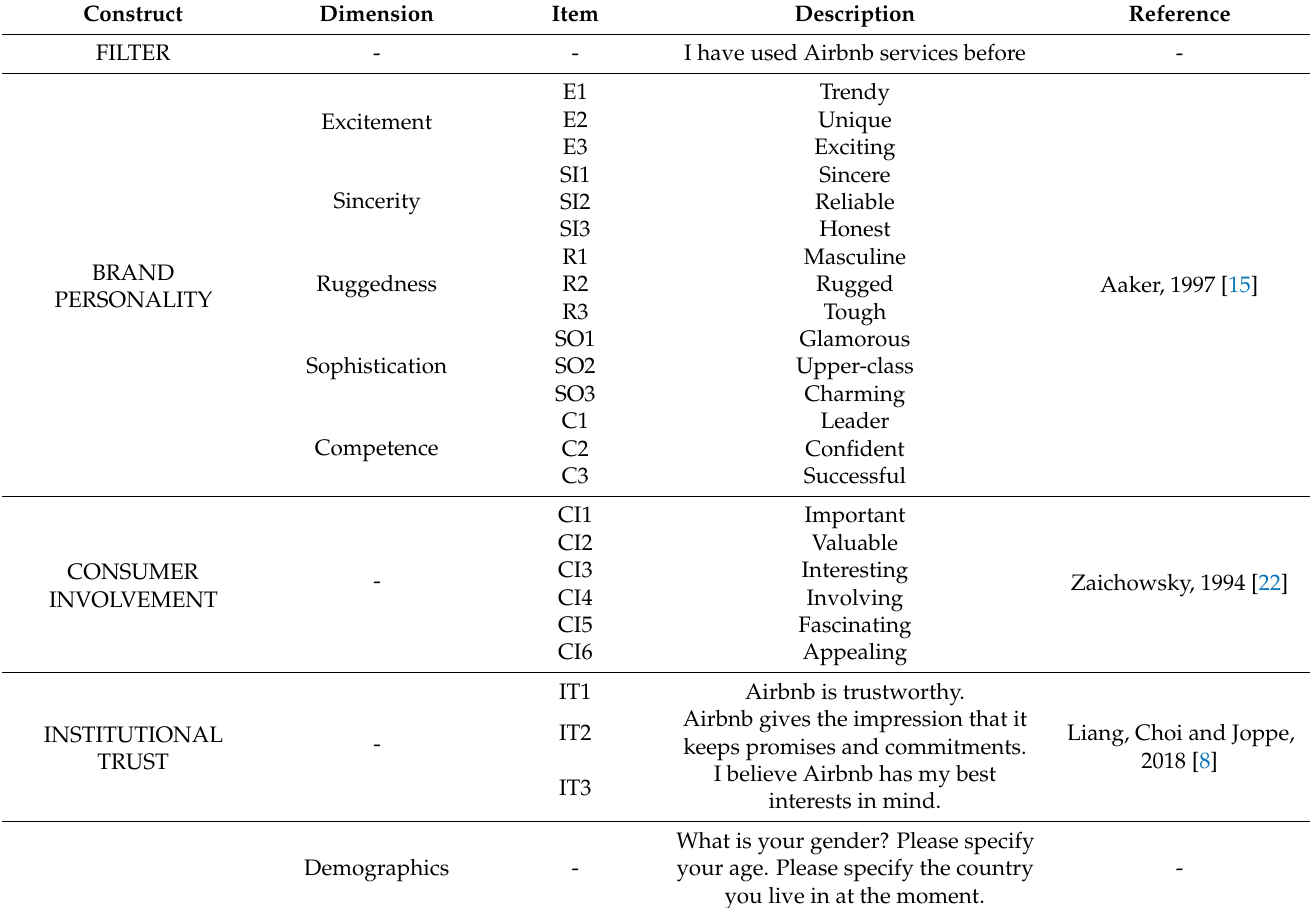
Table 2. Questionnaire